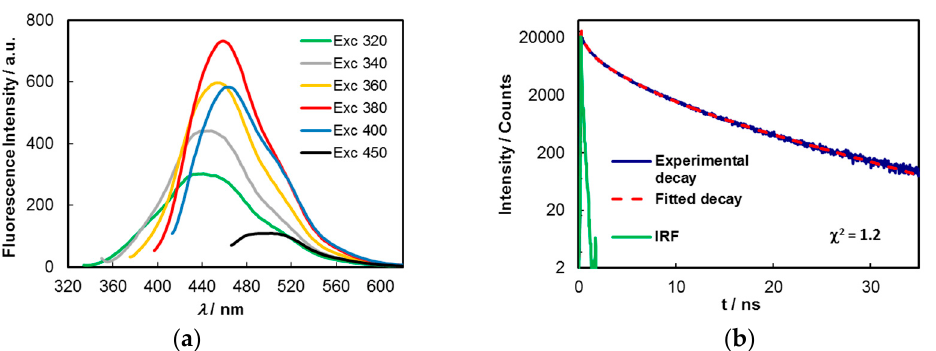
Figure 3. ( a ) Dependency of fluorescence emission of aqueous solutions of C-dots (0.1 mg/mL) upon excitation at different excitation wavelengths; ( b ) time-resolved intensity decay of a buffered solution (pH = 7.2) of C-dots obtained by the single-photon timing method under excitation at 340 nm.